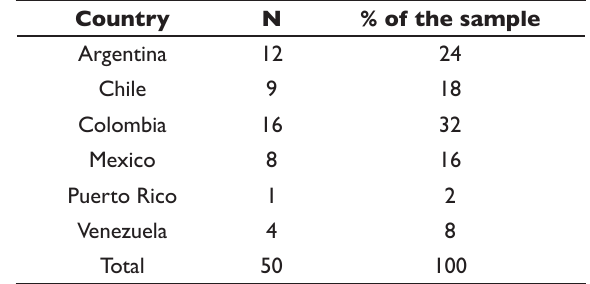
Table 1: Distribution of the sample by country